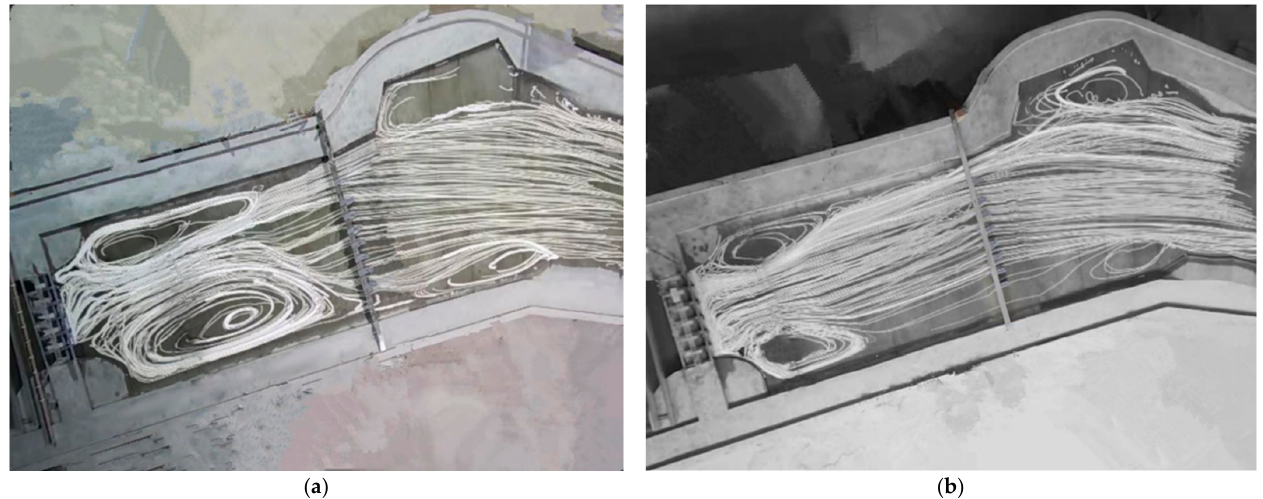
Figure 14. Modified flow patterns in the presence of guide vanes at α = 15°. The water flows from right to left. ( a ) case 1; ( b ) case 2.